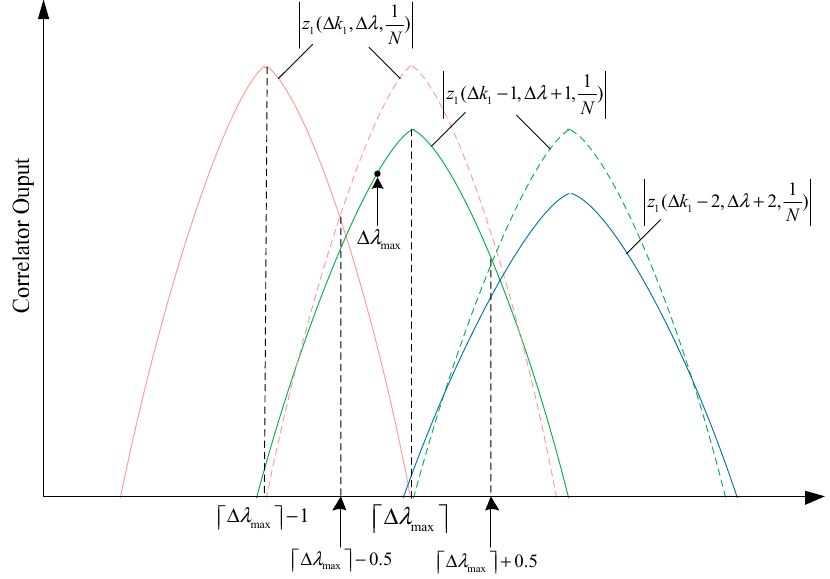
Figure 4. Illustration of the main lobes of the correlator output around the maximum frequency offset λΔ ( λΔ > 0 in this example). The dash line is the copy of the solid one with the same color.